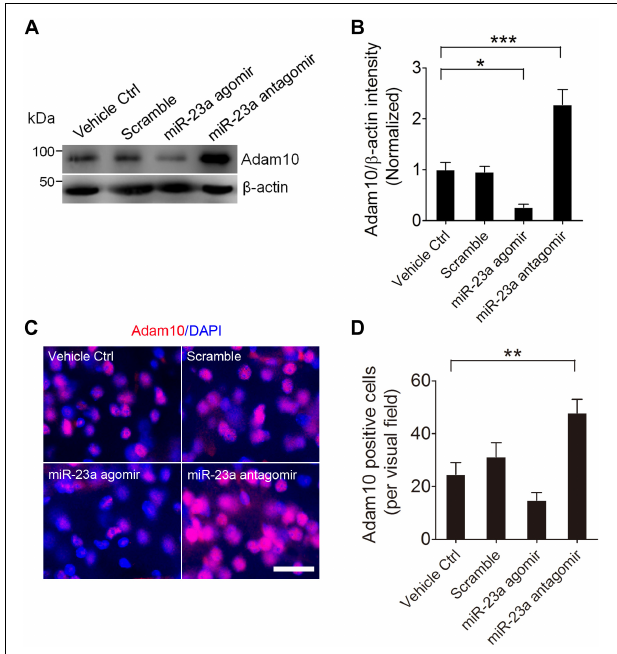
FIGURE 5 | miR-23a down-regulates hippocampal ADAM10 protein level in TLE mice. (A,B) Western blotting analysis of ADAM10 protein levels in the hippocampus of vehicle ctrl, scramble, miR-23a agomir, and miR-23a antagomir-treated TLE mice. ( F 3 , 16 = 22.66, p = 0.042, miR-23a agomir vs. Vehicle Ctrl; p < 0.001, miR-23a antagomir vs. Vehicle Ctrl) ( n = 5). (C) Representative images of the ADAM10 immunostaining in the hilus region of hippocampal DG of vehicle ctrl, scramble, miR-23a agomir, and miR-23a antagomir-treated TLE mice. (D) Bar graphs showing the quantification of ADAM10-positive cells in the hippocampus of the vehicle ctrl, scramble, miR-23a agomir, and miR-23a antagomir-treated TLE mice ( F 3 , 24 = 9.42, p = 0.007, miR-23a antagomir vs. vehicle ctrl) ( n = 7). Values are mean ± SEM. ∗ p < 0.05, ∗∗ p < 0.01, ∗∗∗ p < 0.001, one-way ANOVA. Scale bar = 50 µ